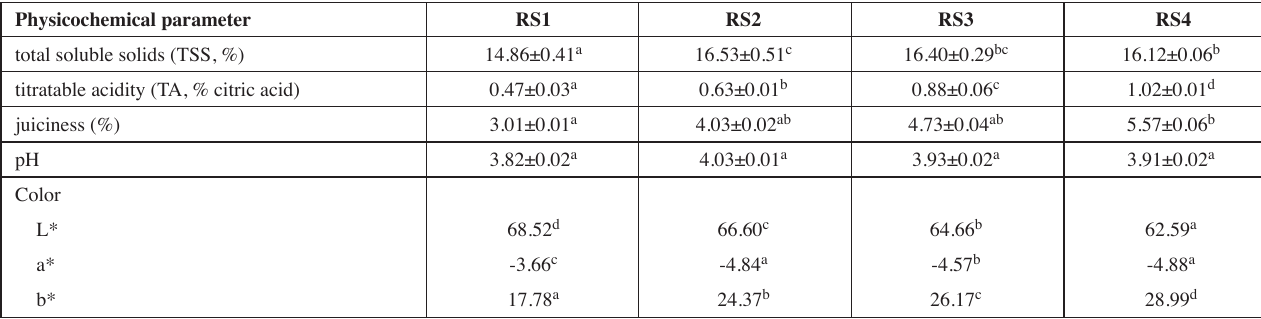
Physicochemical parameter